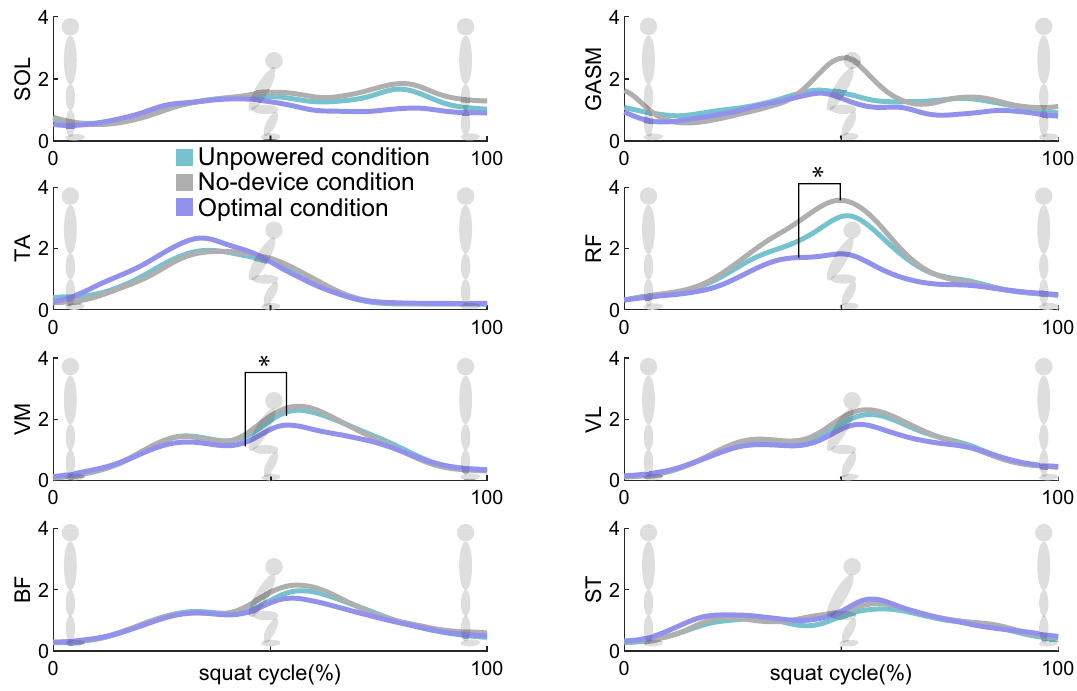
Figure 2. The graphs are the mean trajectories of muscle activations in each condition during squat cycles. 0% is the stance phase, 50% is the bottom point, and 100% is the stand-back point. The blue line is the activation of the optimal condition. The grey line is the no-device condition, and the green line is the unpowered condition trajectory. For statistical expression, * is p <